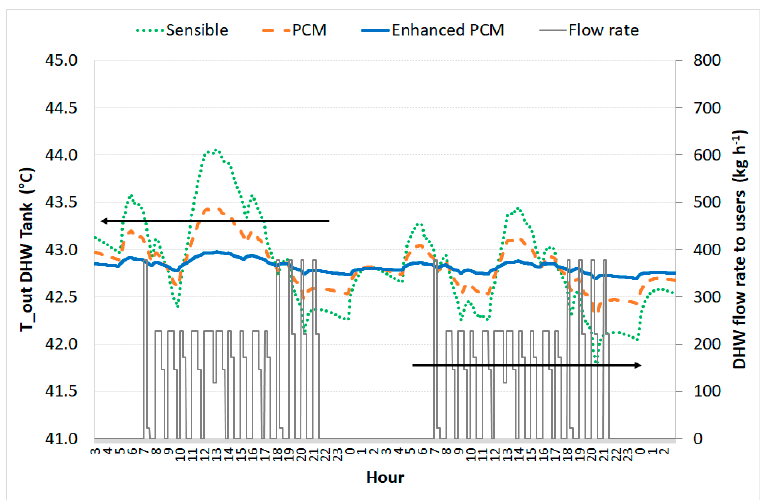
Figure 20. Temperature and flow rate of water at the outlet of the DHW tank in the case of sensible (water), phase change materials (PCM), and the enhanced PCM DHW tank.